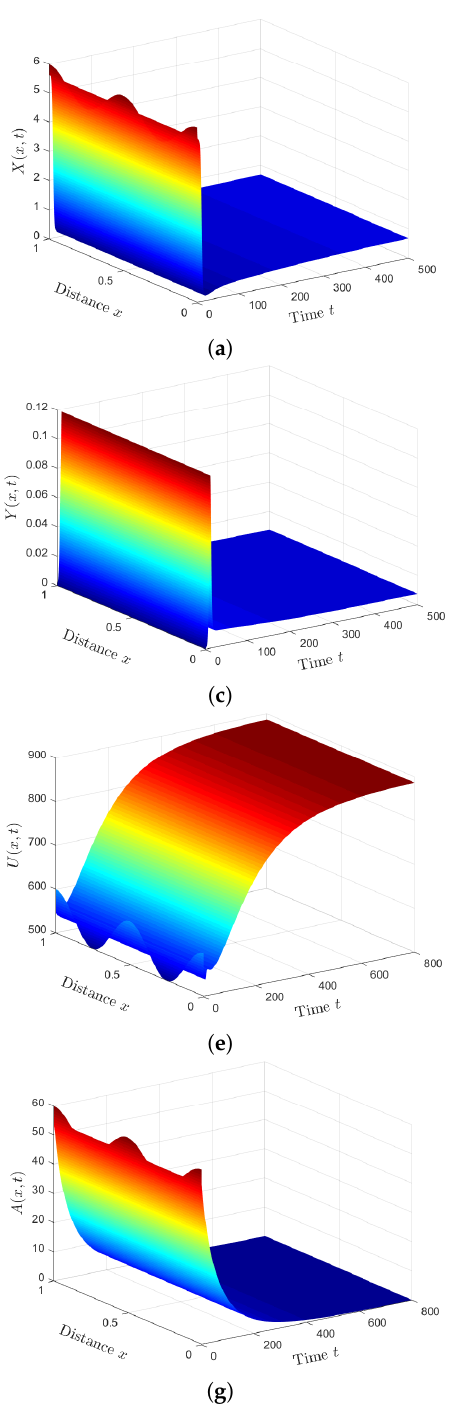
Figure 3. Numerical solution of PDEs (12)–(18) with initial condition (47) and boundary condition (48) in Plan (III). ( a ) Healthy ECs. ( b ) Latent infected ECs. ( c ) Active infected ECs. ( d )